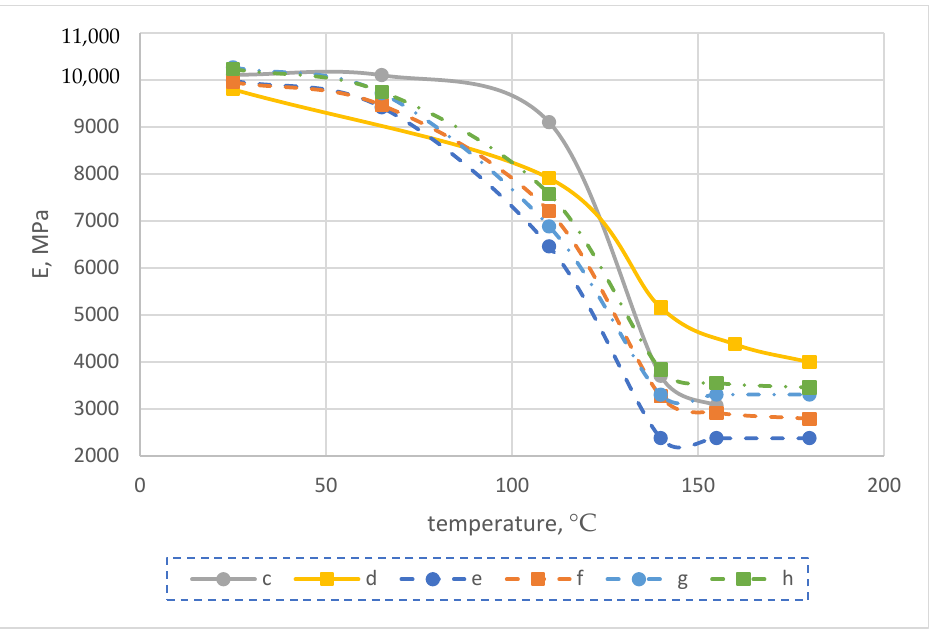
Figure 11. Dependence of elastic modulus on temperature: (c) experimental for the fiberglass specimen before exposure at high temperature; (d) experimental for the fiberglass specimen after exposure at high temperature; (e) computational for the linear calculation of a multilayer composite before exposure at high temperature; (f) computational for the linear calculation of a multilayer composite after exposure at high temperature; (g) computational for the nonlinear calculation of a multilayer composite before exposure at high temperature; (h) computational for the nonlinear calculation of a multilayer composite after exposure at high temperature.